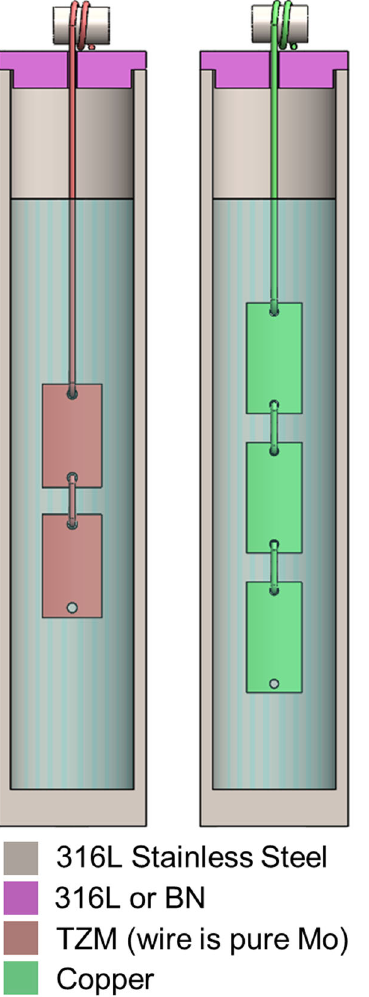
Fig. 6 Schematic of the corrosion cell setup for the salt exposure of TZM and copper samples. Two capsules with separate sample chains were tested such that in one capsule a 316L cap was used to create a galvanic couple between the 316L capsule and the sample chain and in the other capsule a BN cap was used so that the samples were electrically isolated from the 316L